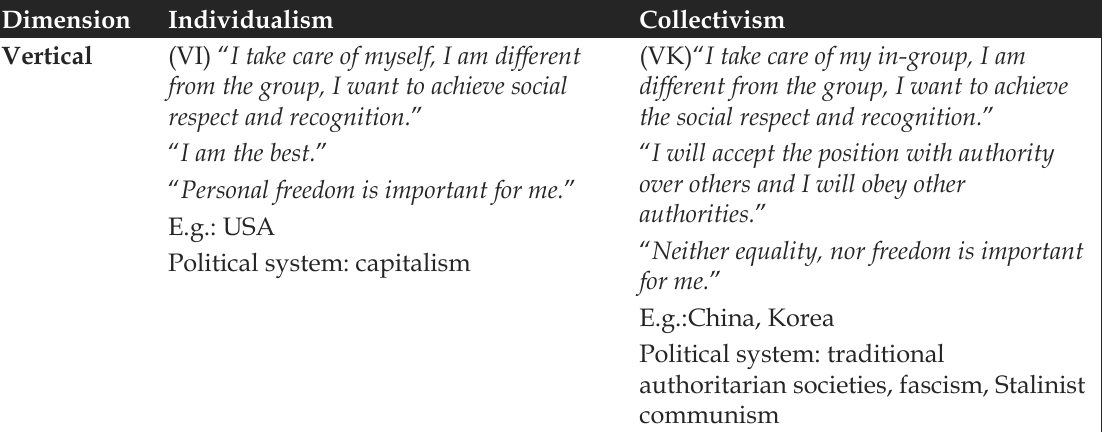
Table 1: Horizontal individualism and collectivism Dimension Individualism Collectivism